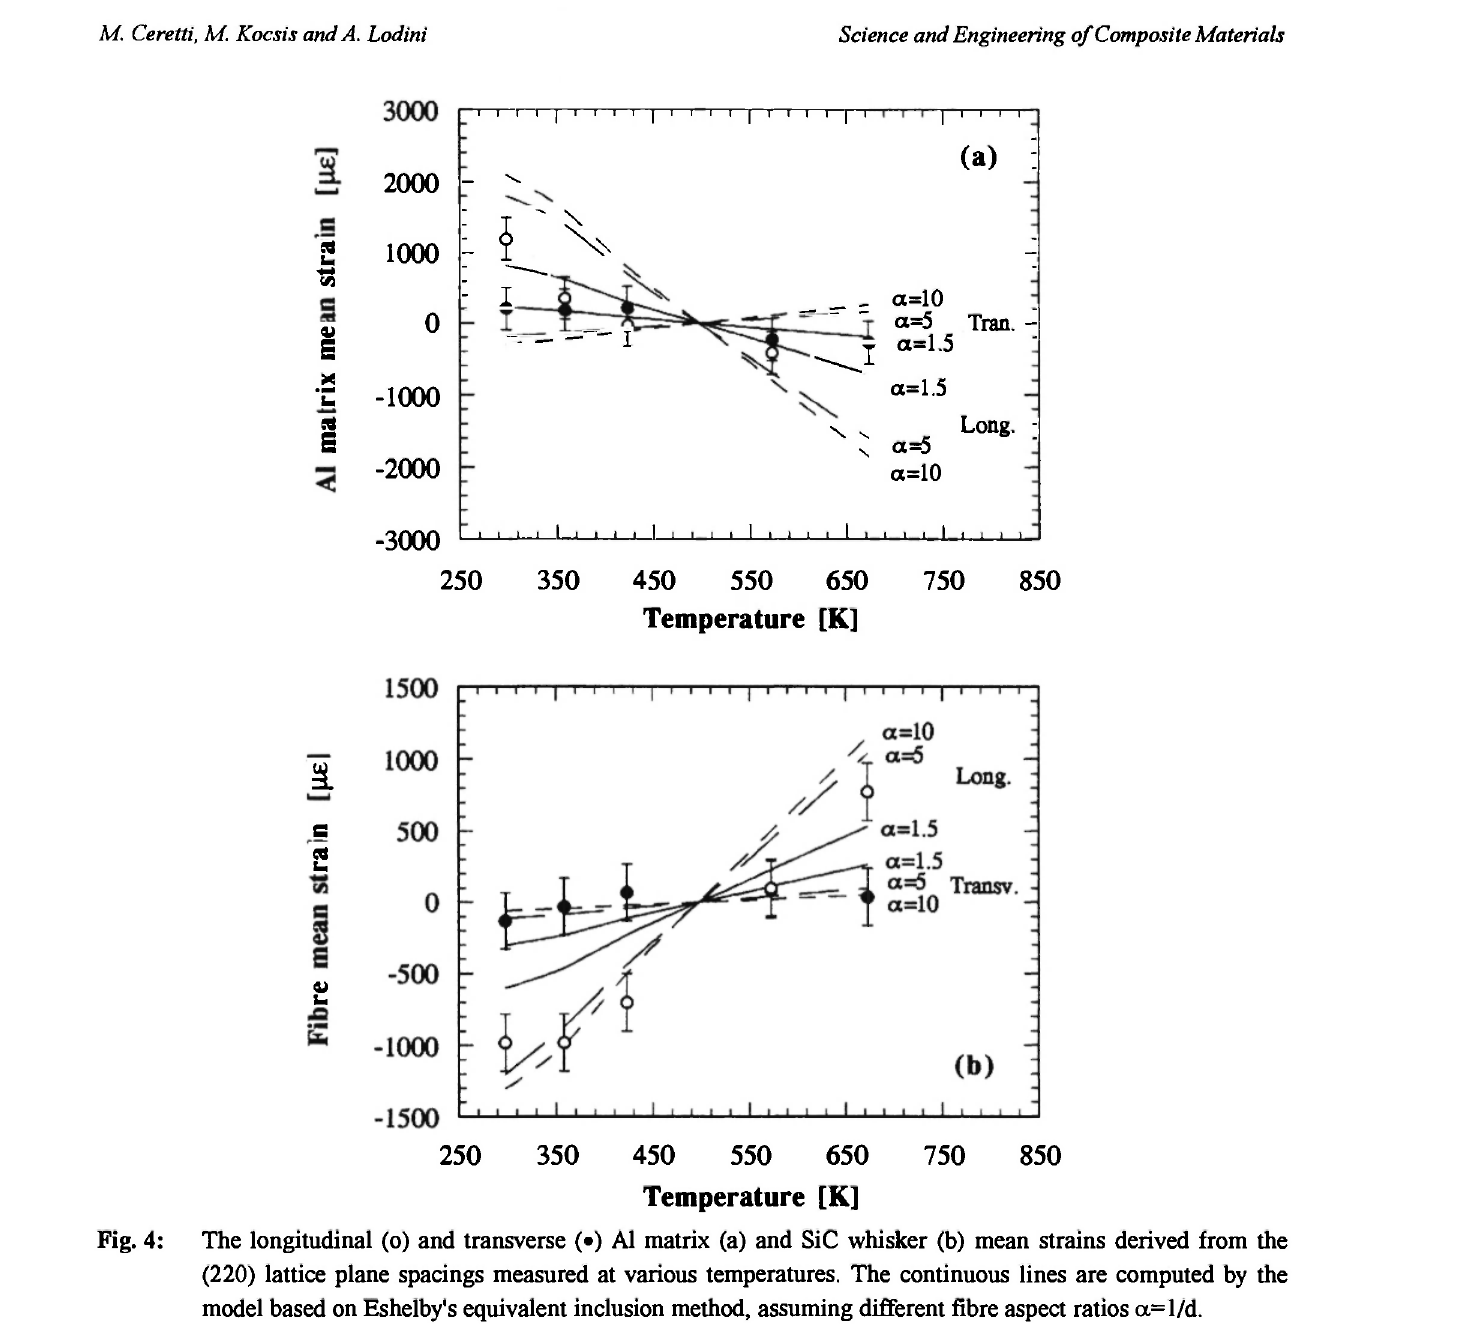
Fig. 4: The longitudinal (o) and transverse (·) Al matrix (a) and SiC whisker (b) mean strains derived from the (220) lattice plane spacings measured at various temperatures. The continuous lines are computed by the model based on Eshelby's equivalent inclusion method, assuming different fibre aspect ratios a=l/d. moduli and Poisson's ratios of the (220) lattice plane of the Al lattice plane (220) follow the same law as the the Al matrix and of the SiCw reinforcement were macroscopic value /38/, the appropriate values of Ε are calculated from the single crystal elastic constants by given in Table 2 below for the different temperatures. the Kröner model. The values of the Poisson's ratios The variation of the macroscopic Young's modulus were assumed to be independent of temperature, while with temperature is less than 2% for the cubic ß-SiC the Young's moduli were introduced as temperature- whiskers over the range 20°C-400°C /39/ and, dependent for the Al matrix only. Supposing that the consequently, the microscopic E220 Young's modulus variations with temperature of the Young's modulus of was also assumed to be independent of the